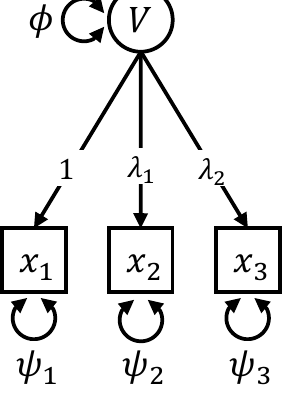
Figure 2. Path diagram of the CFA model. The parameters λ 1 and λ 2 denote factor loadings, φ represents the variance of the latent variable V , and ψ 1 , ψ 2 , and ψ 3 are measurement error